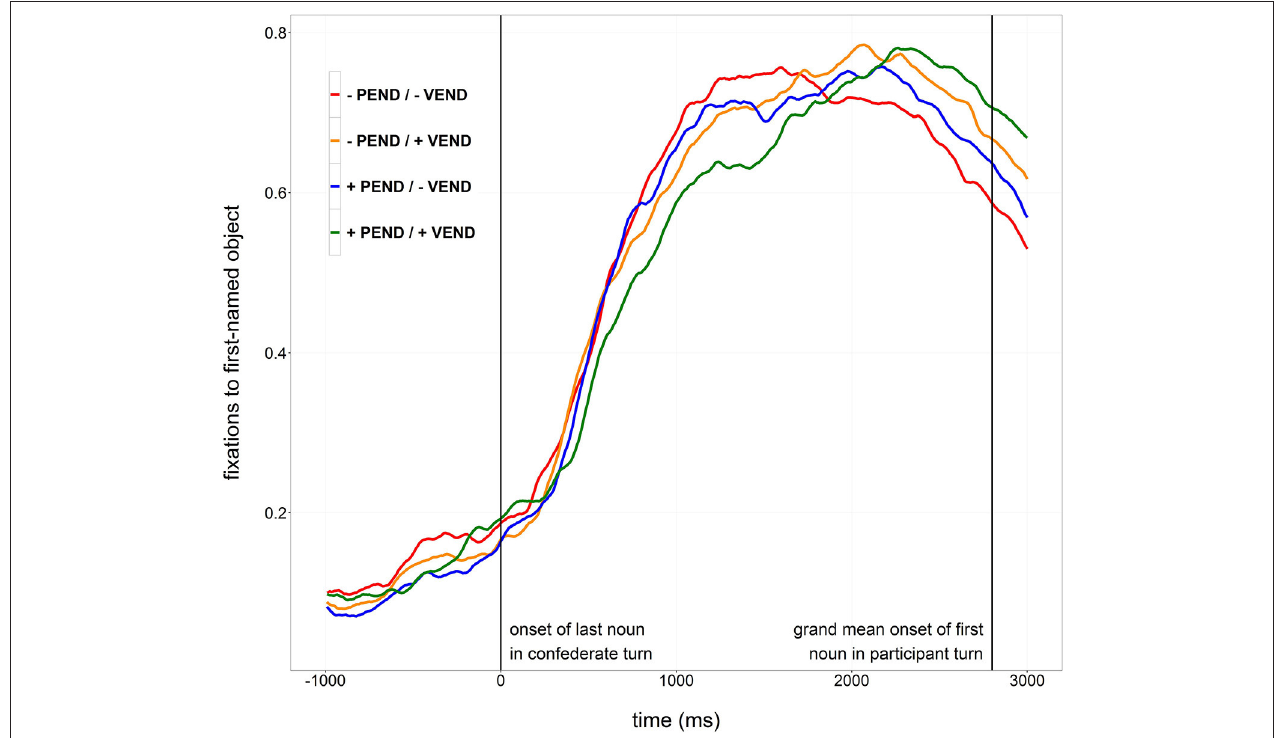
FIGURE 2 | Proportions of looks to the object named first by the participant, time-locked to the onset of the last object noun of the confederate turn (0ms).